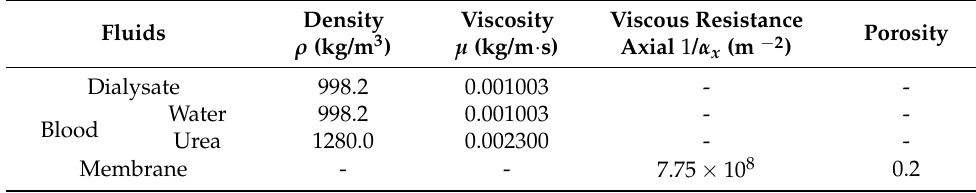
Table 2. Thermo-physical properties and parameters of fluids and membrane [18].